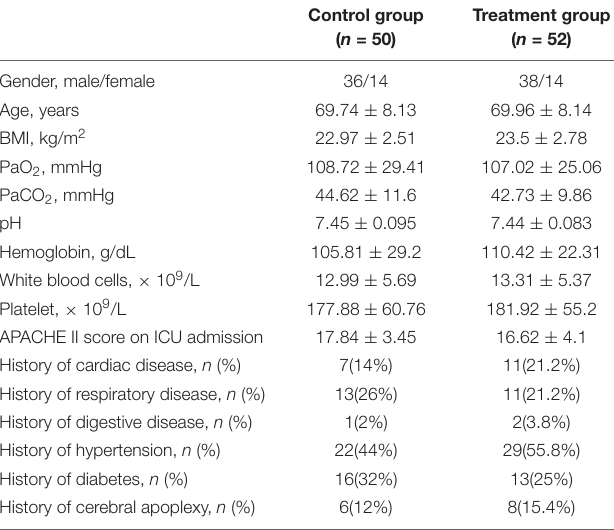
TABLE 1 | Baseline characteristics of patients at inclusion in this trial.